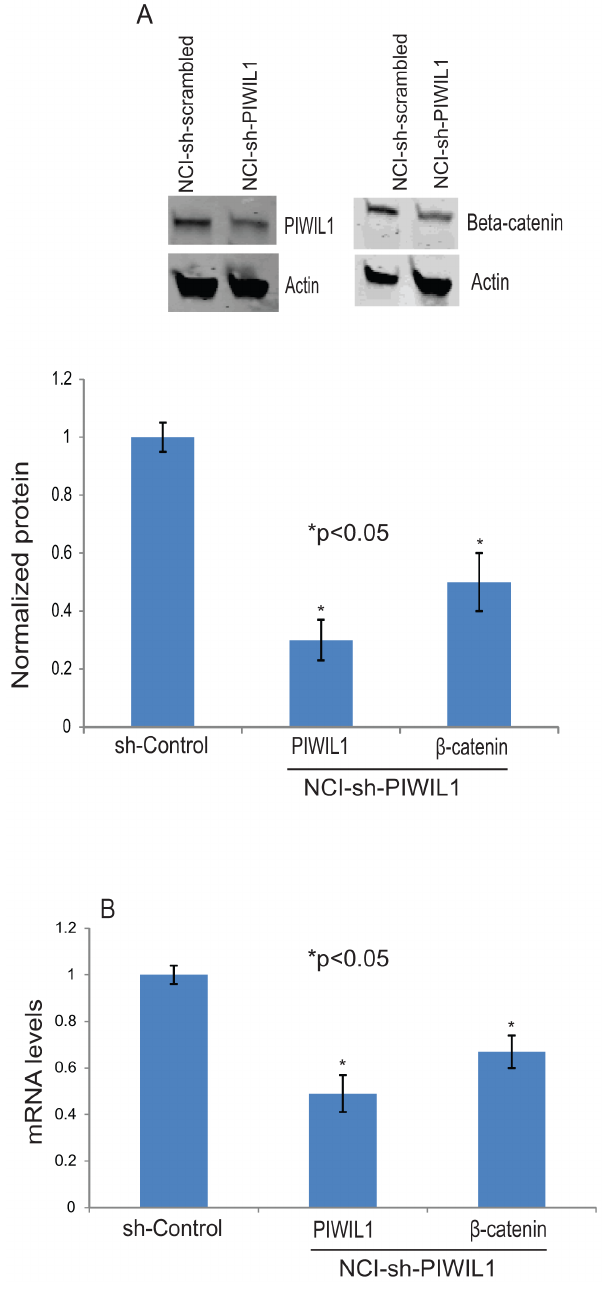
Figure 6 . PIWIL1 silencing reduces b -catenin levels in lung cancer cells . Knock-down of piwil1 expression resulted in a reduction in b -catenin mRNA and protein levels. (A) Western blot analysis of H1299 lung cancer cells infected with Mission Lentiviral-shRNA-control particles (shRNA-cont) and Mission Lentiviral-shRNA- piwil1 (shRNA- piwil1 ) to silence endogenous piwil1 expression. Western blot analysis using anti-PIWIL1 antibody shows reduced PIWIL1 protein levels in shRNA-PIWIL1 cells compared to shRNA-cont cells. Silencing of piwil1 gene expression resulted in a reduction in b -catenin protein levels as determined using b -catenin antibody. Normalized PIWIL1 protein levels to actin (loading control) are also shown, data represents three independent blots. (B) Piwil1 and b -catenin mRNA levels were also assessed in shRNA-cont and shRNA- piwil1 cells and the RT-PCR data show down-regulation of both piwil1 and b -catenin mRNA levels which is consistent with the Western blot analysis. RT-PCR experiments were carried out at least 3 independent times.